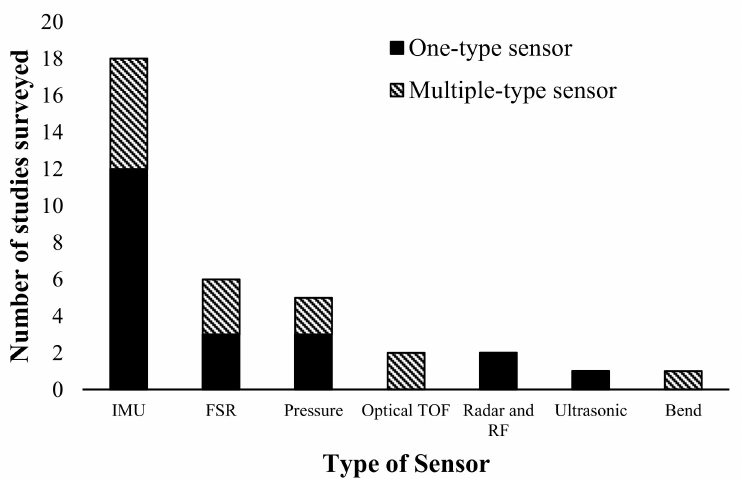
Figure 4. Popularity of types of sensors used in shoes in the literature reviewed. Solid bars show the number of times that the sensor type was used on its own. Diagonal-pattern bars show the number of times that the sensor type was used in combination with other types of sensors. Inertial measurement units (IMUs) are the most popular sensor and have been extensively explored due to their miniature size and negligible cost. Displacement and velocities can be calculated by integrative methods, although the results have limited accuracy and suffer from